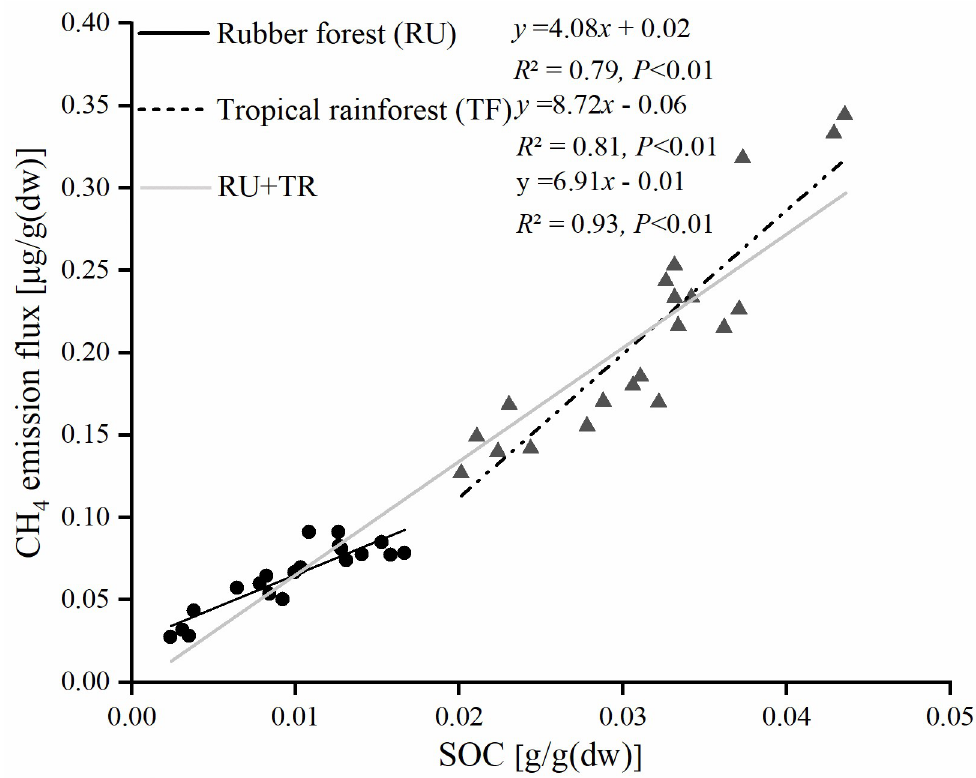
Fig 6. The relationships between soil NM-CH 4 emission fluxes and SOC in the tropical rainforest of